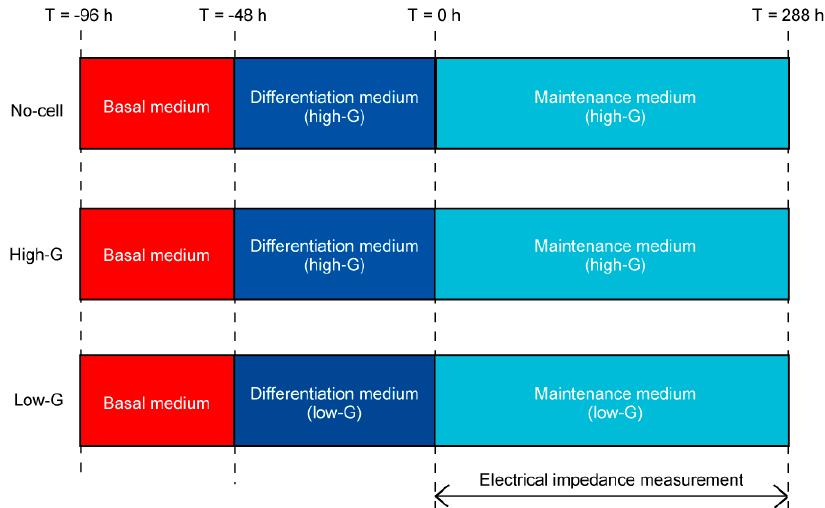
Figure 3. Time-course of cell culture experiments. The 3T3-L1 cells were cultured three-dimensionally in basal medium for 48 h following adipogenesis in differentiation medium for 48 h. After adipogenesis (t = 0 h), the differentiated 3T3-L1 cells were cultured in maintenance medium and the electrical impedance of the cells was measured until t = 288